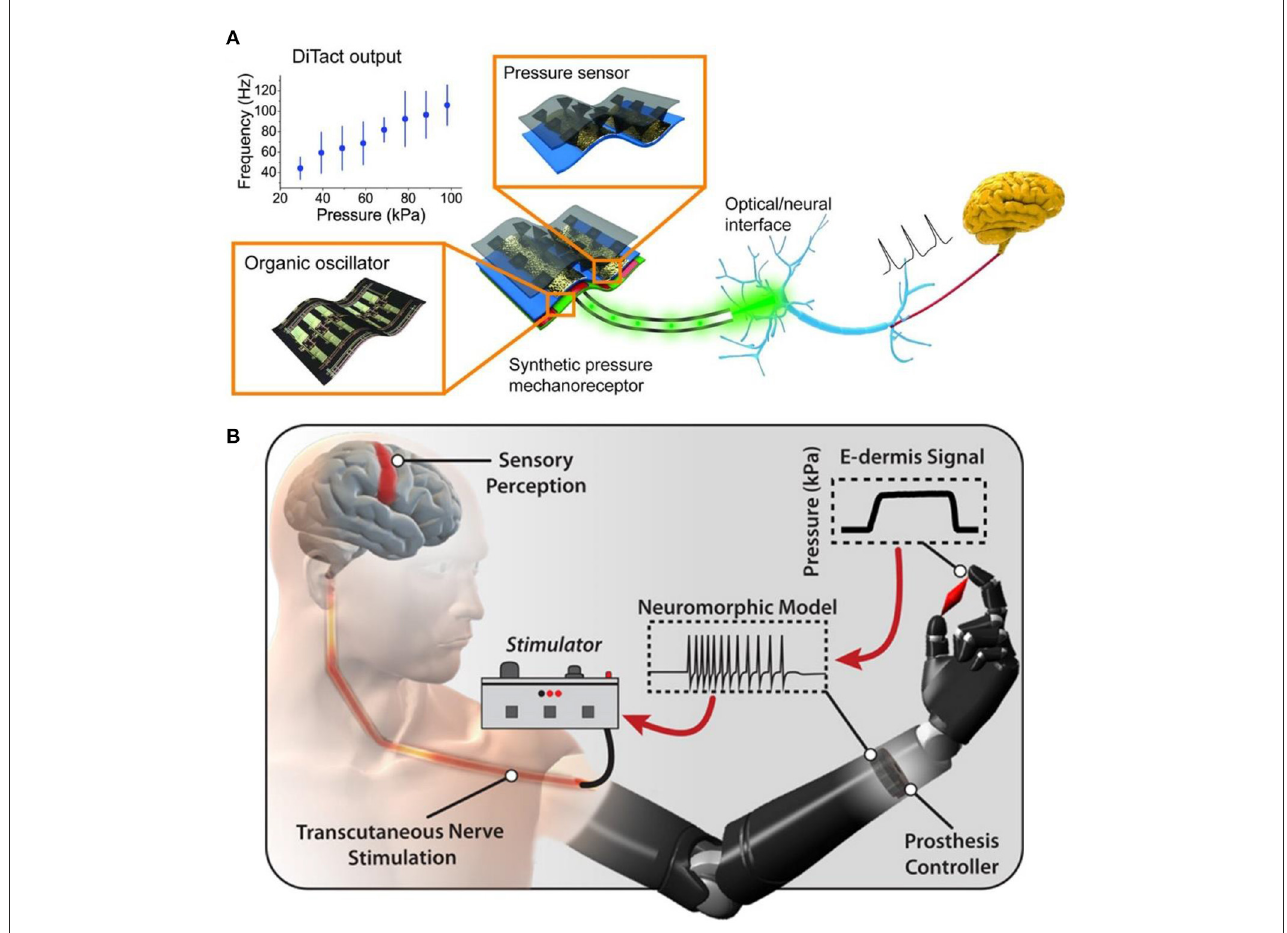
FIGURE6 (A) A power efficient skin-inspired mechanoreceptor reprinted (adapted) with permission from (52), Copyright (2015) The American Association for the Advancement of Science. (B) A neuromorphic interface producing receptor like spiking neural activity for tactile stimuli feedback reprinted (adapted) with permission from (53), Copyright (2018) The American Association for the Advancement of